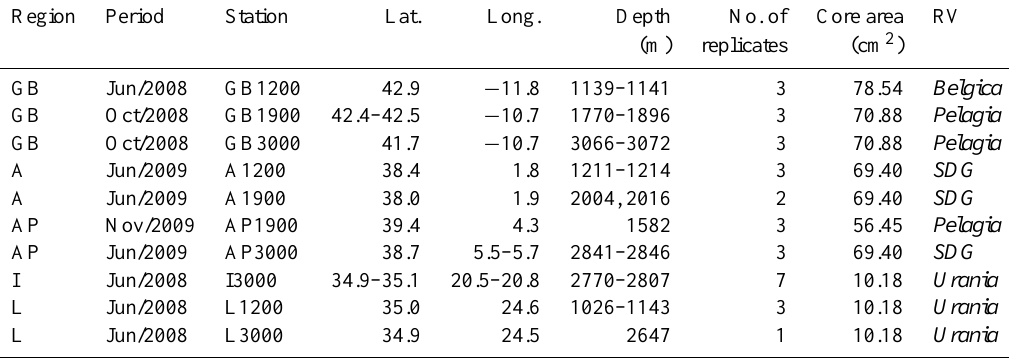
Table 1. Sampling details. Indicated are the region where samples were collected in (GB: Galicia Bank region, A: Algerian Basin, AP: Algero-Provenc¸al Basin, I: Ionian Basin and L: Levantine Basin), station code (representing region and approximate water depth), latitude (lat) and longitude (long), range of water depths over replicates, number of replicate samples, surface area of the core, and the research vessel (RV) aboard which samples were taken (SDG: Sarmiento de Gamboa ). Lat. and long. are expressed in decimal degrees with negative values indicating west (long.) or south (lat.), and positive values indicating east (long.) or north (lat.). Where rounded coordinates of replicates differed, a range is